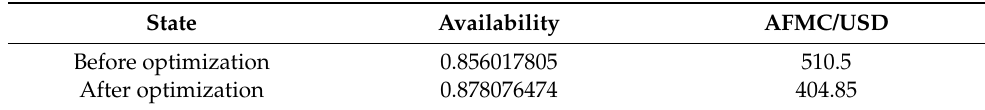
Figure 8. Product life information after optimization. MTBF—mean time between failures. Table 2. Comparison of optimization objectives.